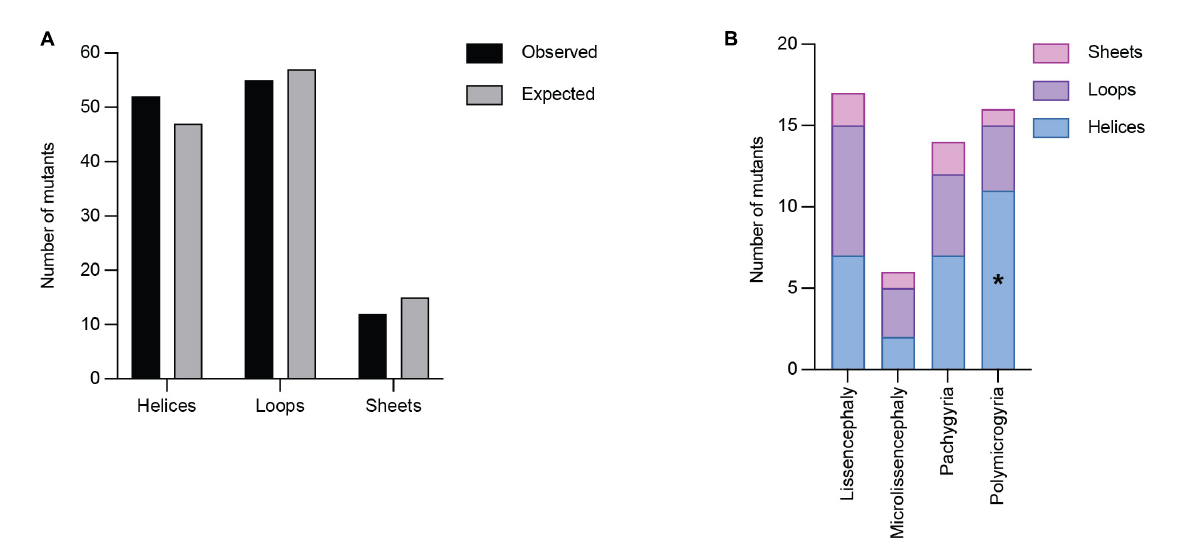
FIGURE5 Quantifying TUBA1A mutations by secondary structure. (A) TUBA1A mutations were sorted by the secondary structural element (helix, loop, or sheet) in which they reside. Observed and expected number of mutations were compared using a Chi-squared test [5.99 critical value when α = 0.05; X 2 (df = 2, N = 119) = 1.202; p = 0.55]. The expected number of mutations in each secondary structure was calculated by determining the percentage of amino acids that reside in each structure, then multiplying that by 119 (the number of TUBA1A missense mutations known to date). This value represents the number of mutations that would be expected to appear in each structure if all 119 mutations were randomly distributed. (B) TUBA1A mutations were sorted by the primary cortical malformation resulting from each mutation (lissencephaly, microlissencephaly, pachygyria, or polymicrogyria). For each cortical malformation, the number of mutations in each secondary structural element was reported. A Fisher’s exact test was run for each cortical malformation category to determine if mutations were enriched in one secondary structure over the others. Asterisk (*) on bar indicates p -value < 0.05 (polymicrogyria helices p = 0.03).